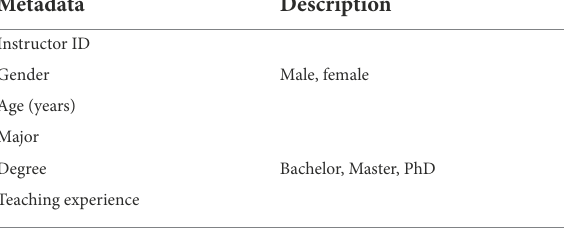
TABLE 5 Metadata for